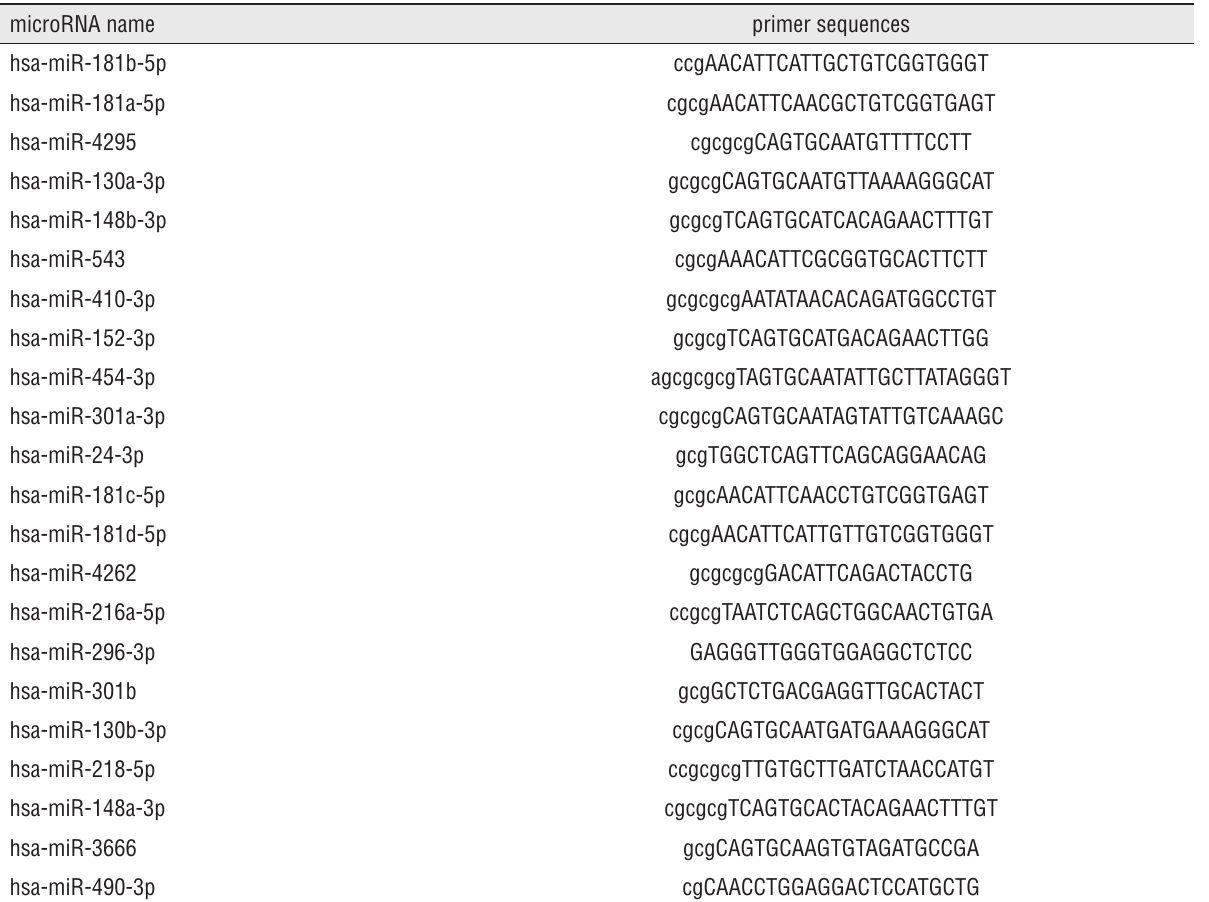
Supplemental Table1 - The primer sequences of all the